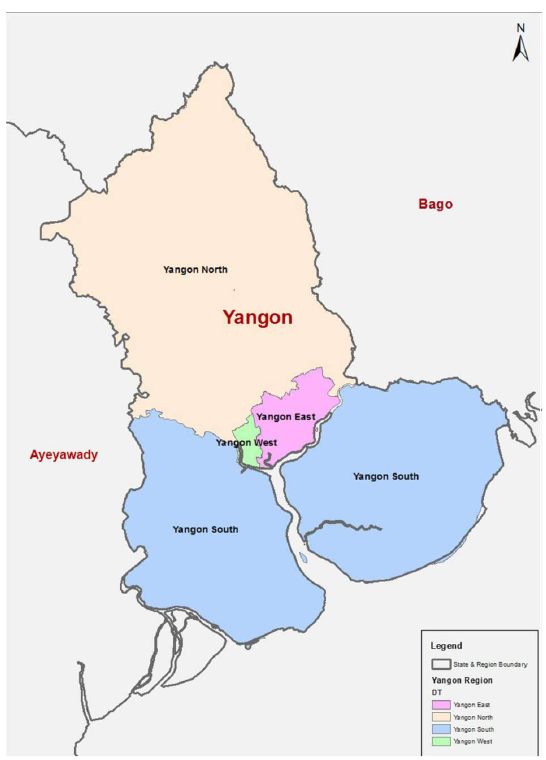
Figure 1. Map of the Yangon Region by Districts. Source: The 2014 Myanmar Population and Housing Census: Yangon Region Report. [17]